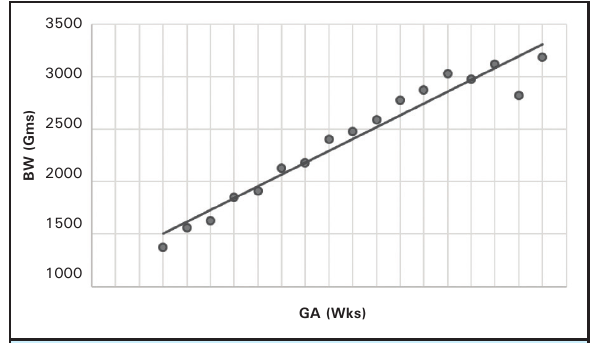
Figure 2. Smoothed curve for birth